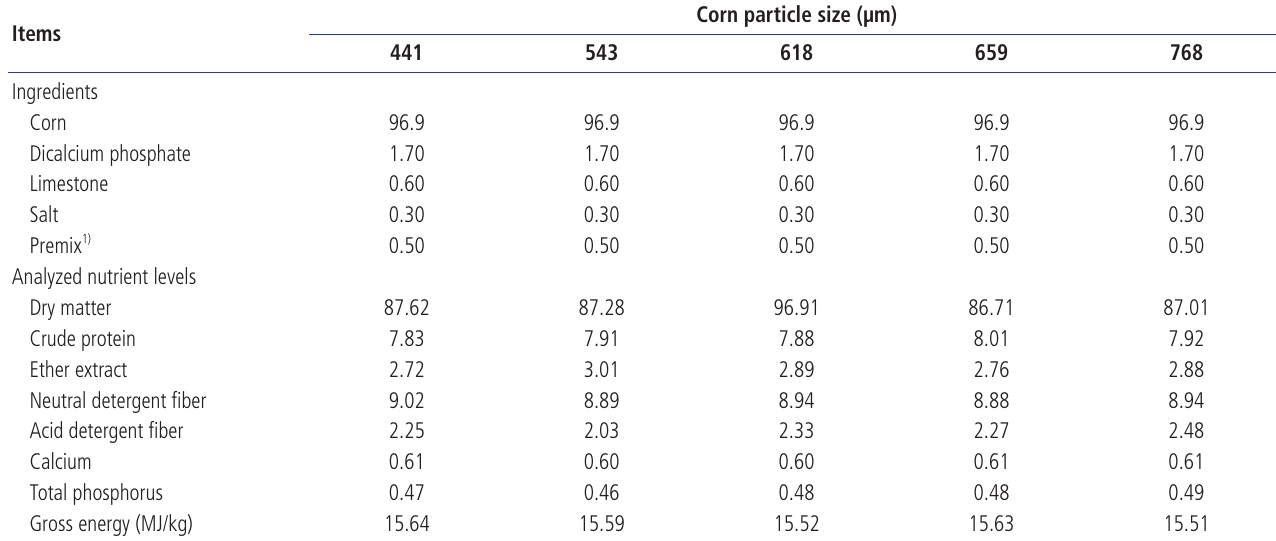
Table 2. The ingredient and analyzed chemical compositions of experimental diets for growing pigs in experiment 1 (%, as-fed basis) Items